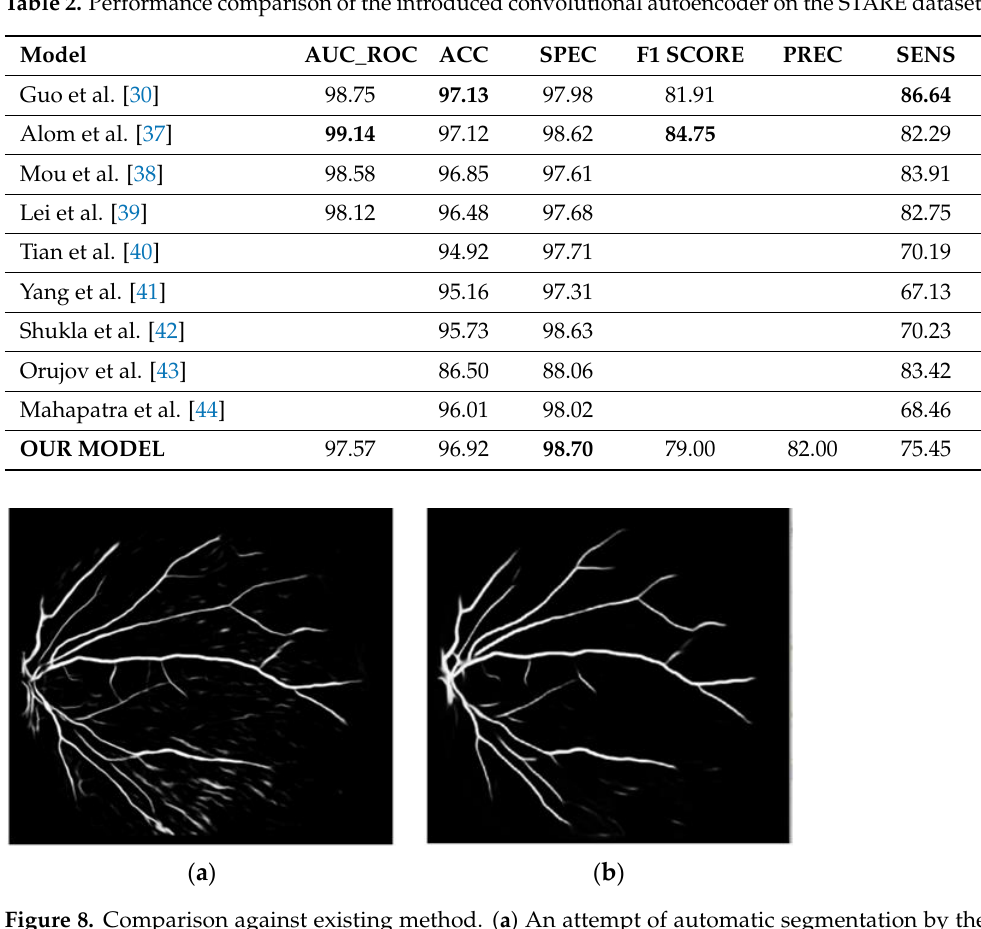
Table 2. Performance comparison of the introduced convolutional autoencoder on the STARE dataset. Model